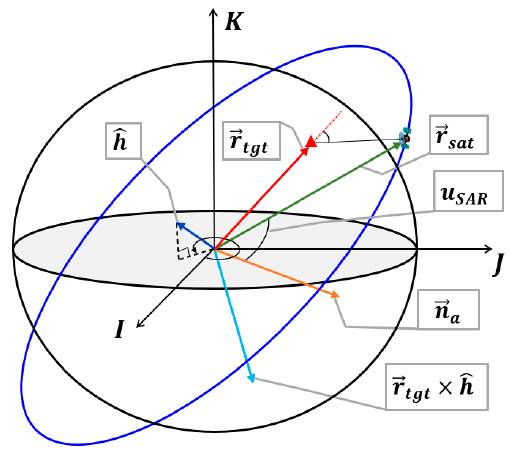
→ → r tgt , r sat , and RADN op Figure 12. Geometric relationships between ˆ h , Figure 12. Geometric relationships between ℎ(cid:3552) , 𝑟⃗ (cid:3047)(cid:3034)(cid:3047) , 𝑟⃗ (cid:3046)(cid:3028)(cid:3047) , and 𝑅𝐴𝐷𝑁 (cid:3042)(cid:3043) . 4.1.2. Obtaining the Precise 𝑅𝐴𝐷𝑁 (cid:3042)(cid:3043) Using a Numerical Method 𝑅𝐴𝐷𝑁 (cid:3042)(cid:3043) calculated by the geometric method is inaccurate because it is based on a two-body problem that does not reflect perturbations such as non-spherical Earth, atmospheric drag, third body gravities (Sun, Moon), and solar radiation. 𝑅𝐴𝐷𝑁 (cid:3042)(cid:3043) and 𝑒𝑝𝑜𝑐ℎ (cid:3020)(cid:3002)(cid:3019) obtained using a geometric method for a target located in mid-latitudes generate a squint angle, the angle between the vertical plane of the satellite’s velocity and the position vector of the target, of approximately 6° and 𝜃 (cid:3036)(cid:3041)(cid:3030) error of approximately 5°. This error increases as the latitude of the target increases. For the target located below the latitude of 70°, the squint angle and 𝜃 (cid:3036)(cid:3041)(cid:3030) errors were 15° and 10° or less, respectively. To obtain accurate 𝑅𝐴𝐷𝑁 (cid:3042)(cid:3043) and 𝑒𝑝𝑜𝑐ℎ (cid:3020)(cid:3002)(cid:3019) values, numerical methods are applied in the coverage of ±1.5° and ±40 s to the geometrically obtained 𝑅𝐴𝐷𝑁 (cid:3042)(cid:3043) and 𝑒𝑝𝑜𝑐ℎ (cid:3020)(cid:3002)(cid:3019) , respectively. Here, the ±1.5° for 𝑅𝐴𝐷𝑁 (cid:3042)(cid:3043) makes the numerical method search approximately ±10° coverage around the geometrically calculated 𝜃 (cid:3036)(cid:3041)(cid:3030) , and the ±40 s for 𝑒𝑝𝑜𝑐ℎ (cid:3020)(cid:3002)(cid:3019) makes the numerical method search approximately ±20° coverage around the geometrically calculated squint angle. The precise 𝑅𝐴𝐷𝑁 (cid:3042)(cid:3043) and 𝑒𝑝𝑜𝑐ℎ (cid:3020)(cid:3002)(cid:3019) are obtained as